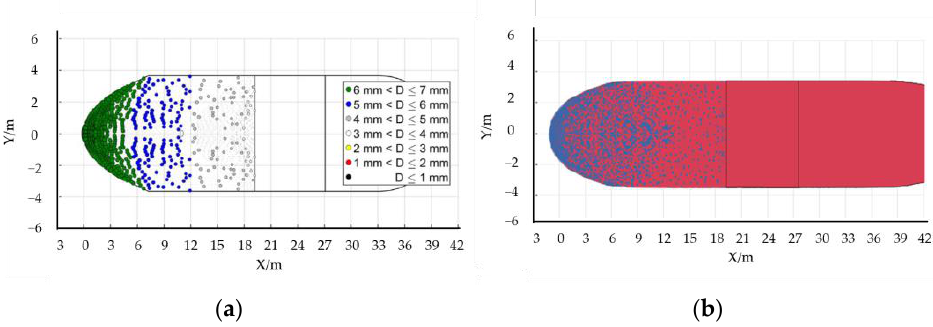
Figure 7. The deck droplet distribution for both models: ( a ) Dehghani et al. (2018) droplet distribution in the impact deck [40] and ( b ) SPH model arithmetic example of droplet distribution on impact deck. Table 2. A comparison between the results of 2-D and 3-D models, field observations, and previous